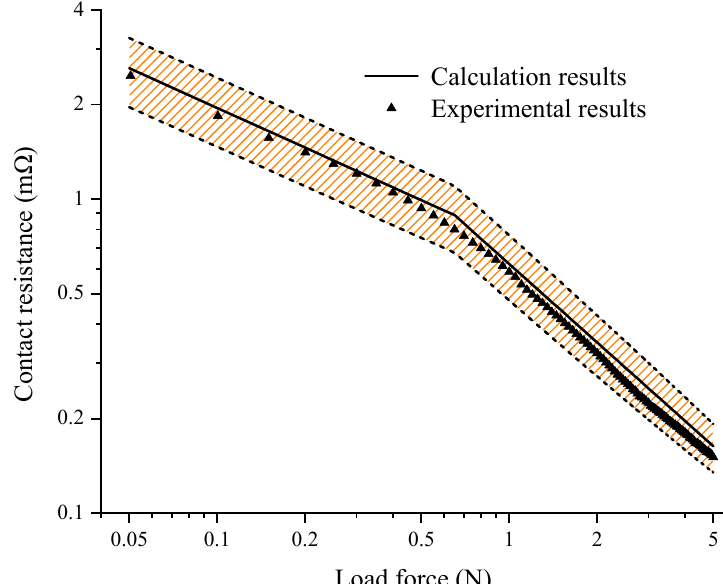
Figure 11. Comparison of contact resistance calculation and experimental